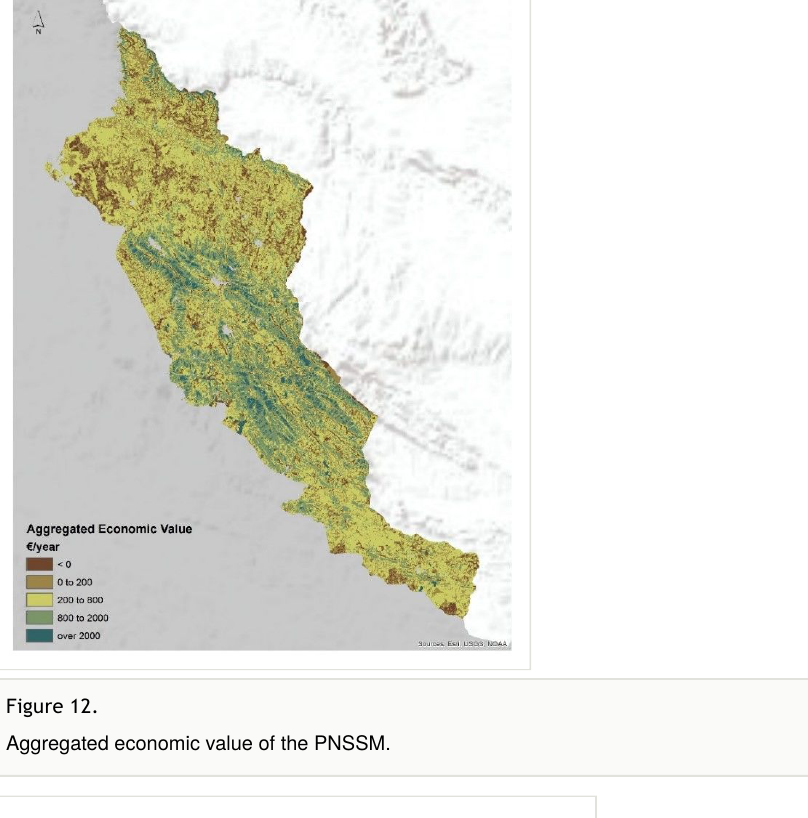
Figure 12. Aggregated economic value of the PNSSM.